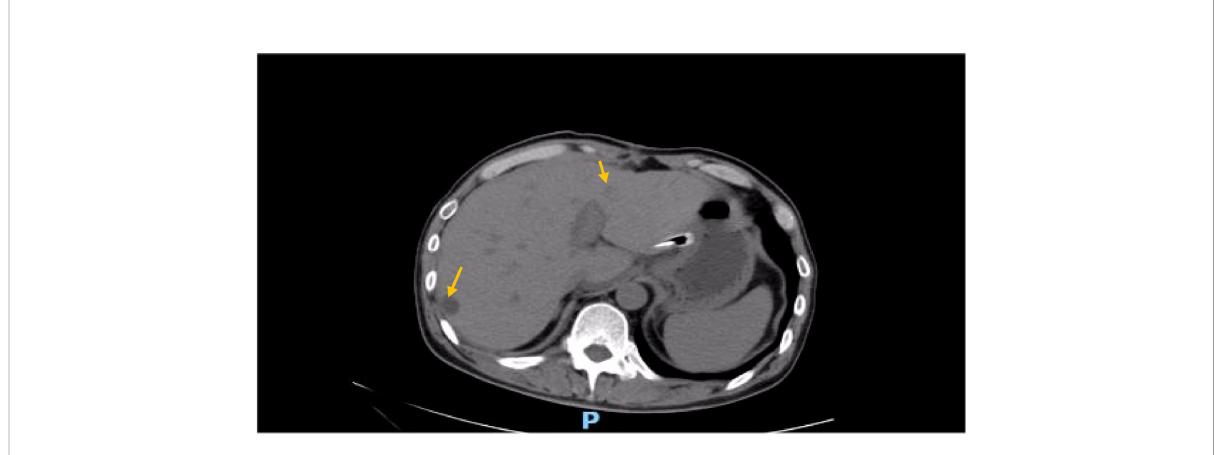
FIGURE 4 CT (liver metastasis) was